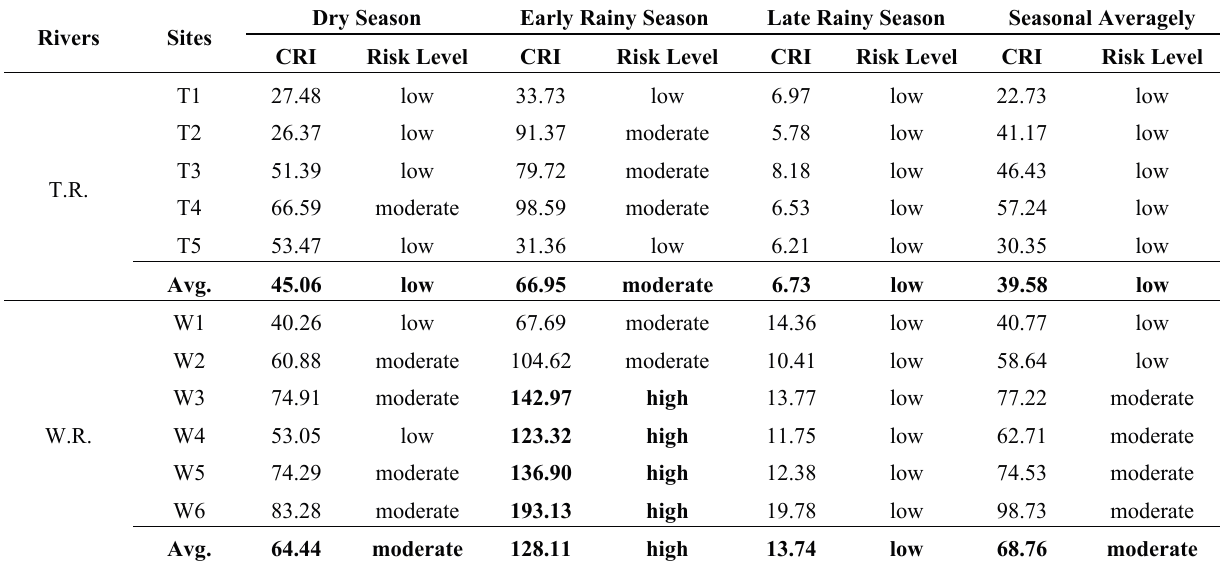
Table 3 . Comprehensive risk indices (CRIs) and potential integrated risks posed by metal pollution in the Taipu River (T.R.) and the Wusong River